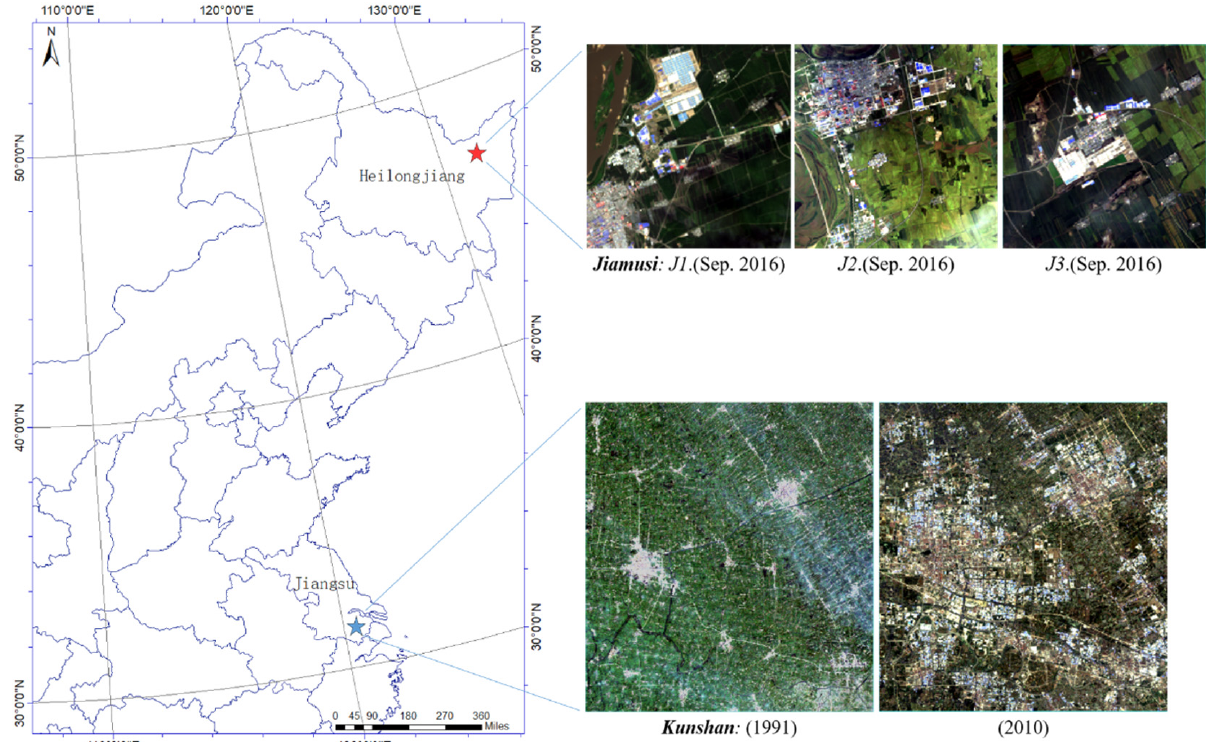
Figure 5. Study area locations of Jiamusi and Kunshan . We used three small areas ( J1 , J2 , and J3 ) with the size of 256 × 256 pixels in Jiamusi from 2015 to 2016. The Kunshan data spans from 1991 to 2010, and the image size is 1005 × 937 pixels.